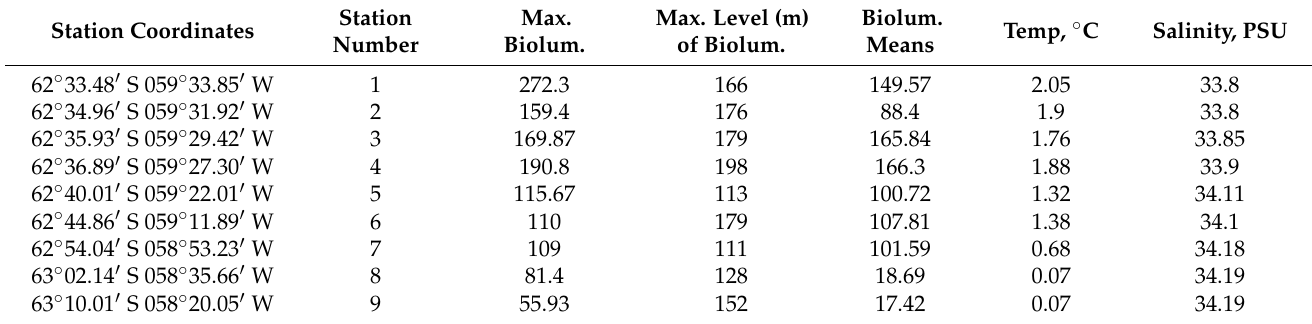
Table 1. Mean of bioluminescence, temperature, and salinity at several stations in the region.